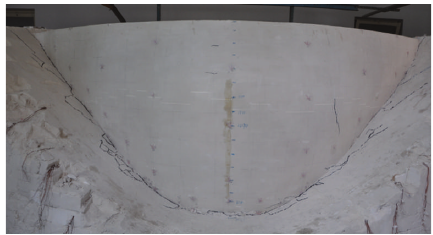
Figure 20: The final distribution of upstream